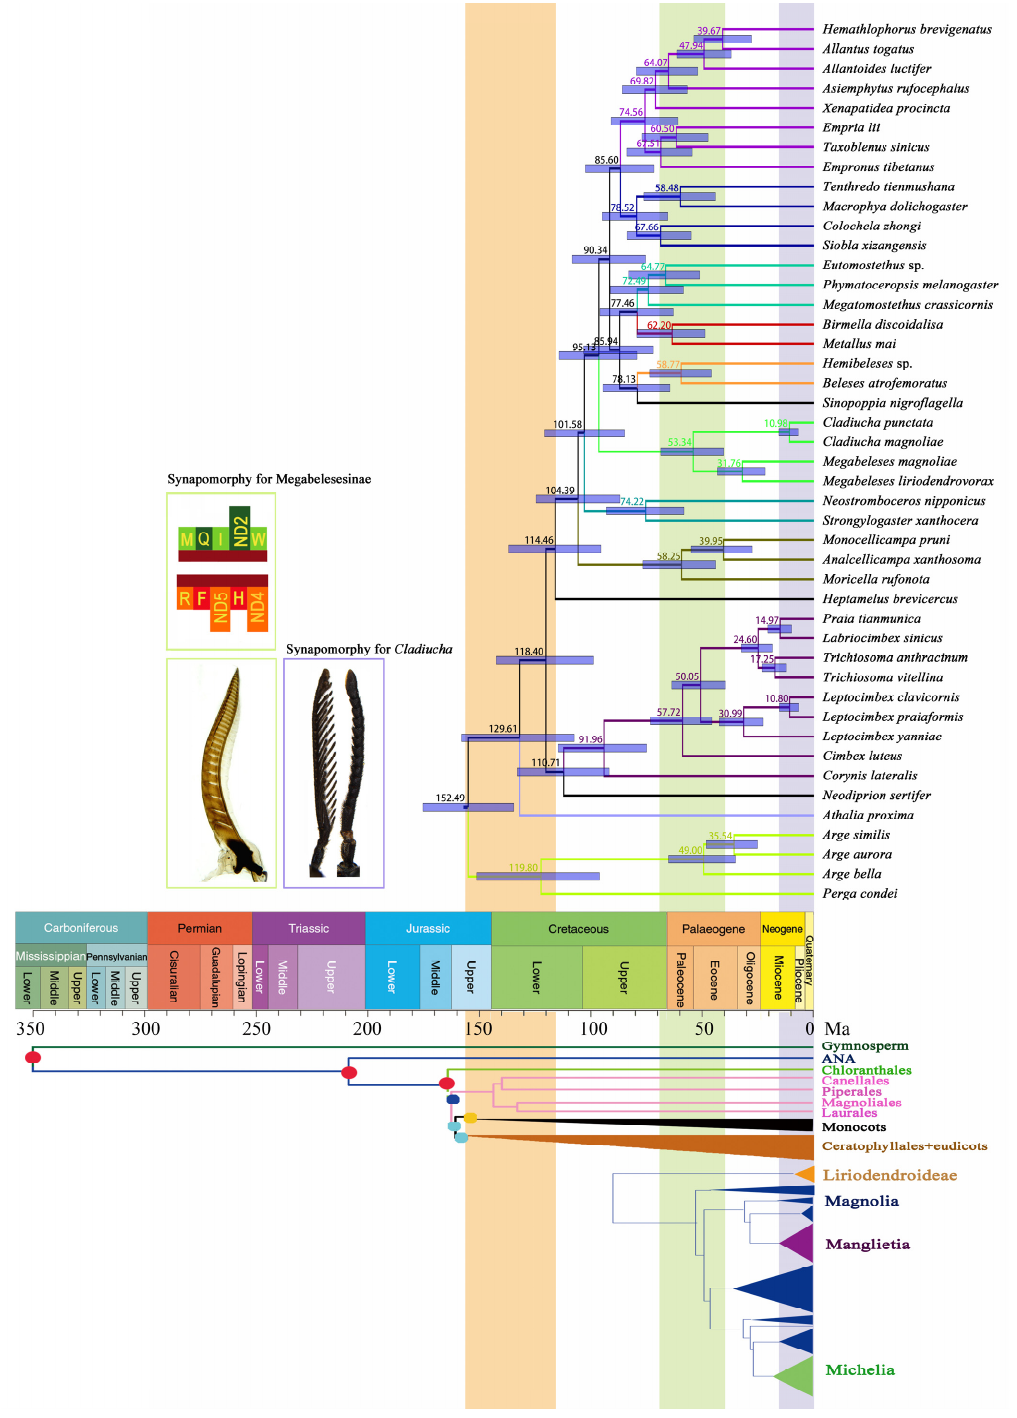
Figure 7. Dated phylogeny constructed with P123RNA dataset in BEAST v1.8.3. The axis on the bottom refers to million years and shows the geological time. The blue bars on the nodes represent 95% of the high posterior density of divergence times obtained from the MCMC tree. The divergence times of each node obtained from the MCMC tree analysis are written in black on the nodes. The yellow shaded area delineates the arising of Tenthredinoidea, while the green and purple shaded areas delineate the arising of Megabelesesinae and Cladiucha , respectively, depending on the minimum or maximum ages. The traits in green and purple boxes are their synapomorphies, respectively. The phylogenetic trees given at the bottom are the angiosperm tree and the Magnolia tree,